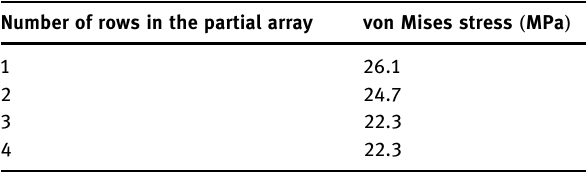
Table 7: Solder maximum von Mises stress results in several row con fi gurations Number of rows in the partial